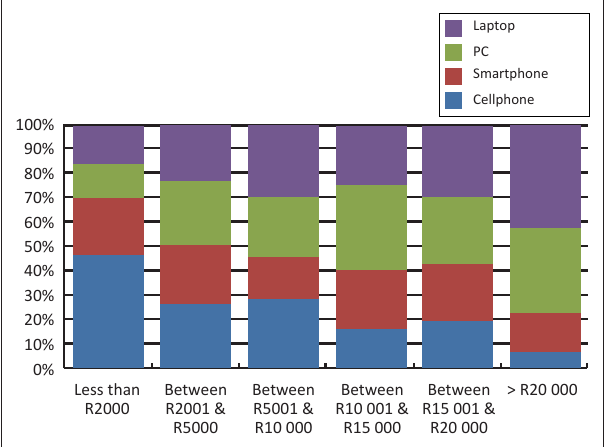
FIGURE 13: Monthly income versus type of